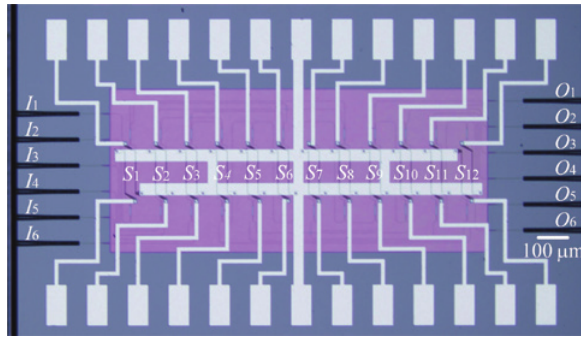
Figure 3: Microscope image of the fabricated optical switch.